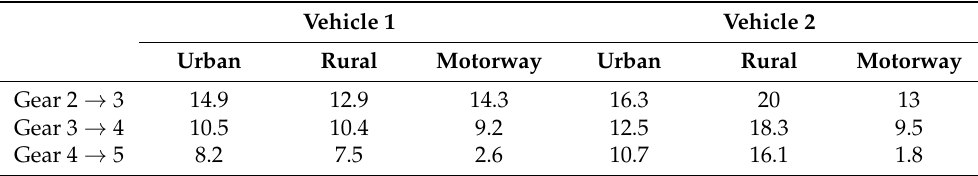
Table 6. Average percentage fuel consumption reduction factor after selection of higher gear, calculated for motion conditions as recorded during the measurements.